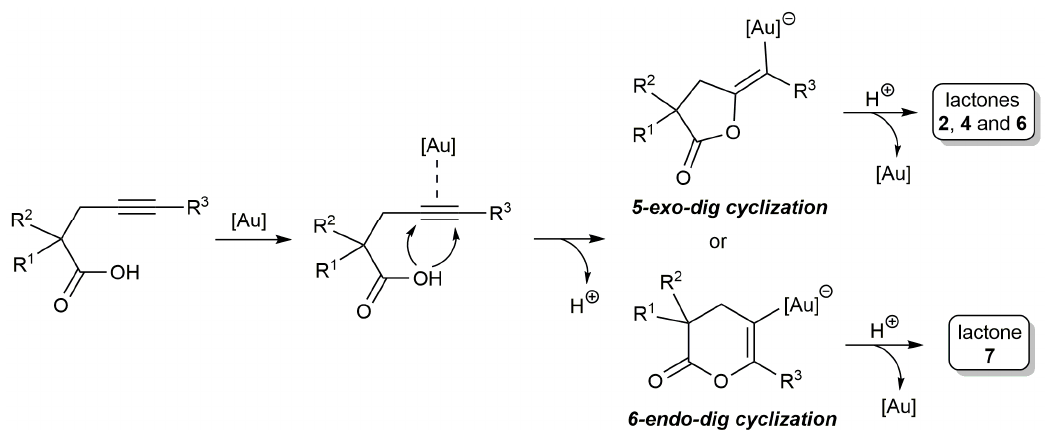
Scheme 3. Proposed mechanism for the AuCl-catalyzed cycloisomerization of γ -alkynoic acids.